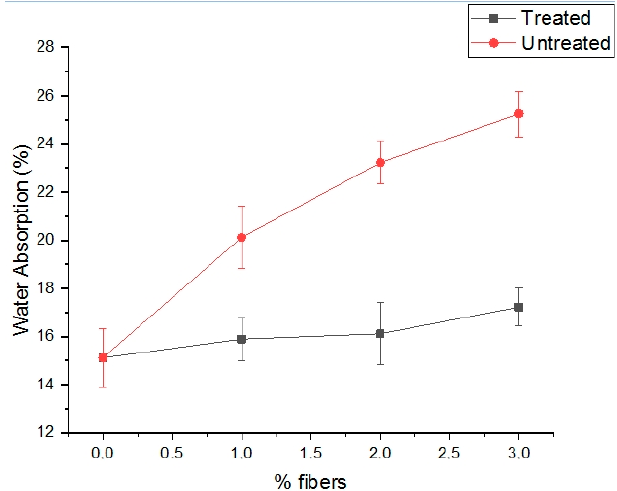
Figure 4. Water absorption of mortars.